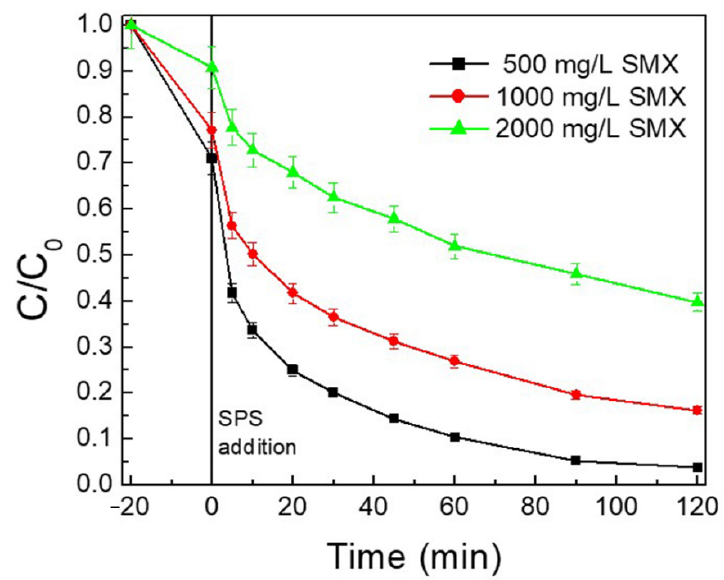
Figure 11. Effect of initial SMX concentration on its degradation with 100 mg/L biochar (RHB 850) and 500 mg/L SPS in UPW and pH = 5.6.